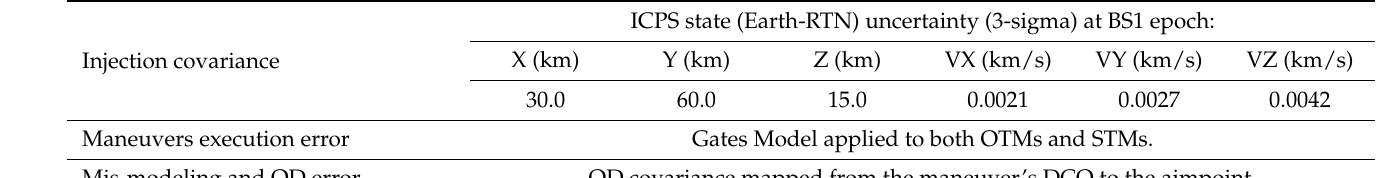
Table 2. Considered trajectory statistical errors in the Flight Path Control analysis.